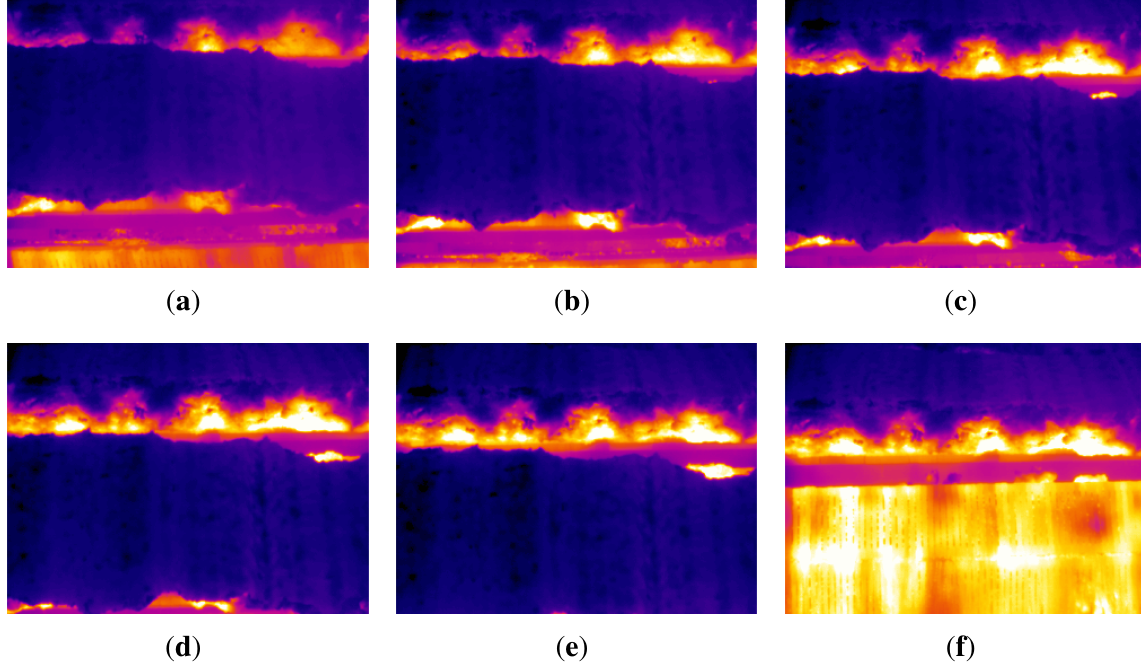
Figure 5. Infrared images acquired while the sinter is being discharged. ( a ) Image at t = 0 ; ( b ) image at t = 1 . 6 s; ( c ) image at t = 3 . 2 s; ( d ) image at t = 4 . 8 s; ( e ) image at t = 6 . 4 s; ( f ) image at t = 8 s key frame where the flame front is clearly